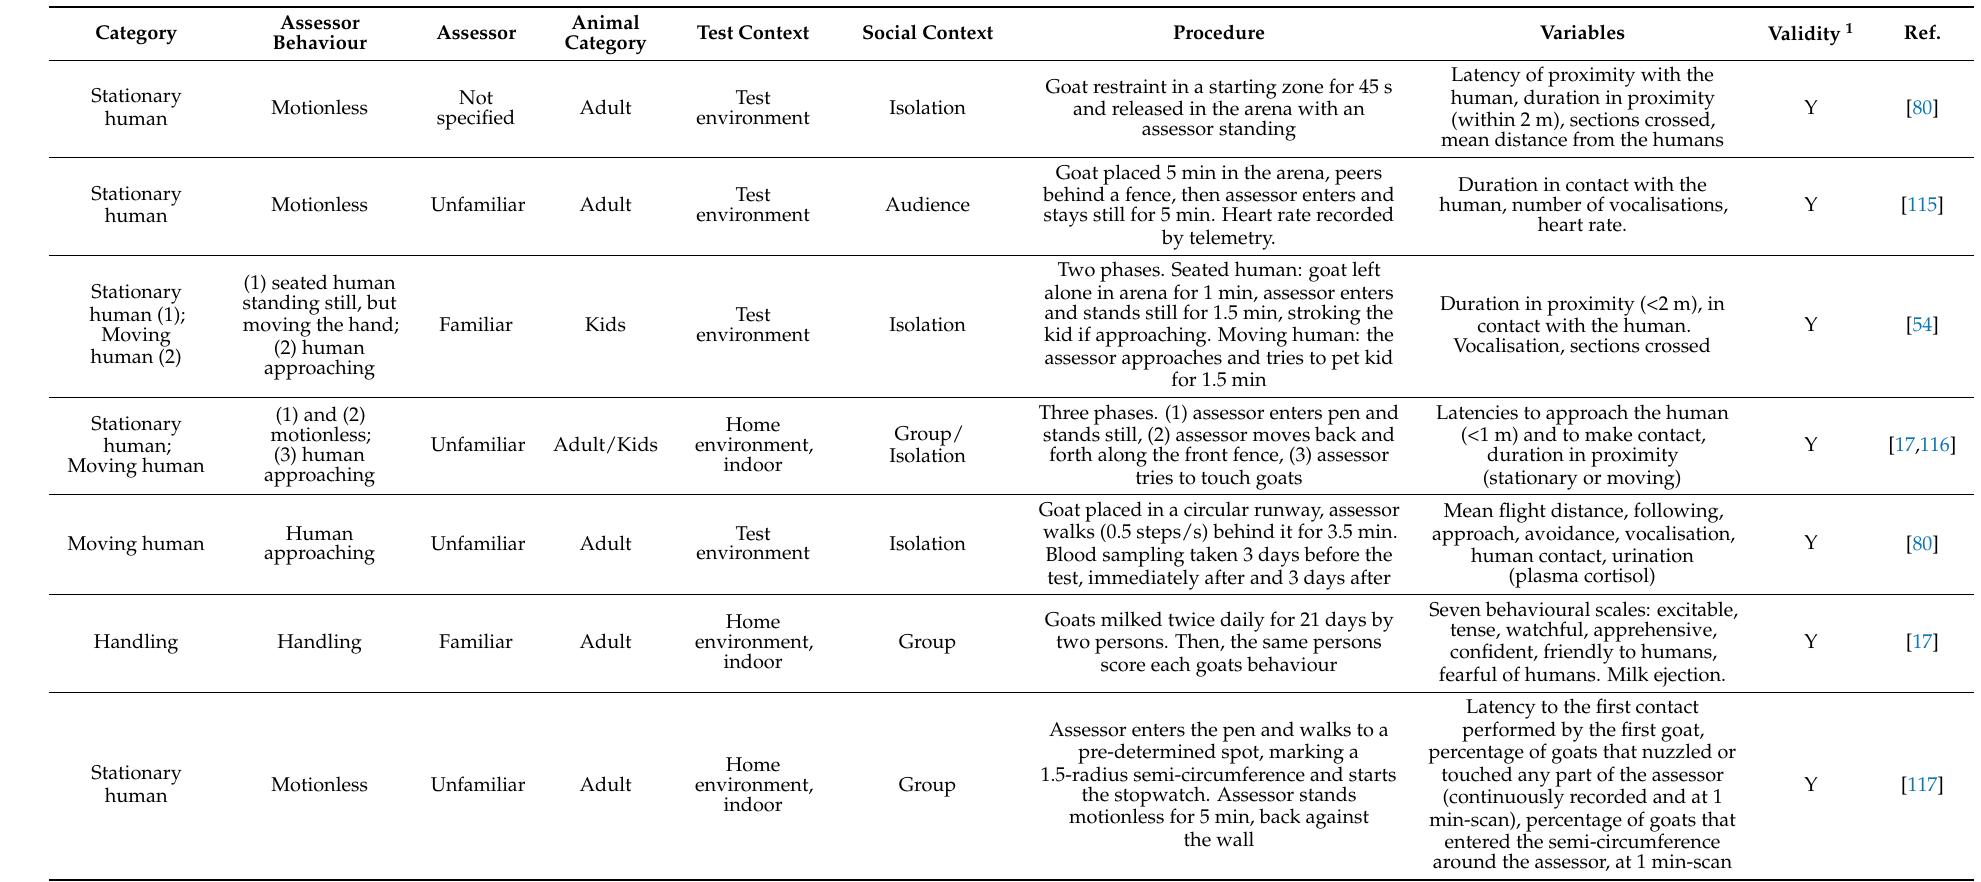
Table 3. Behavioural tests for evaluating the quality of human–goat